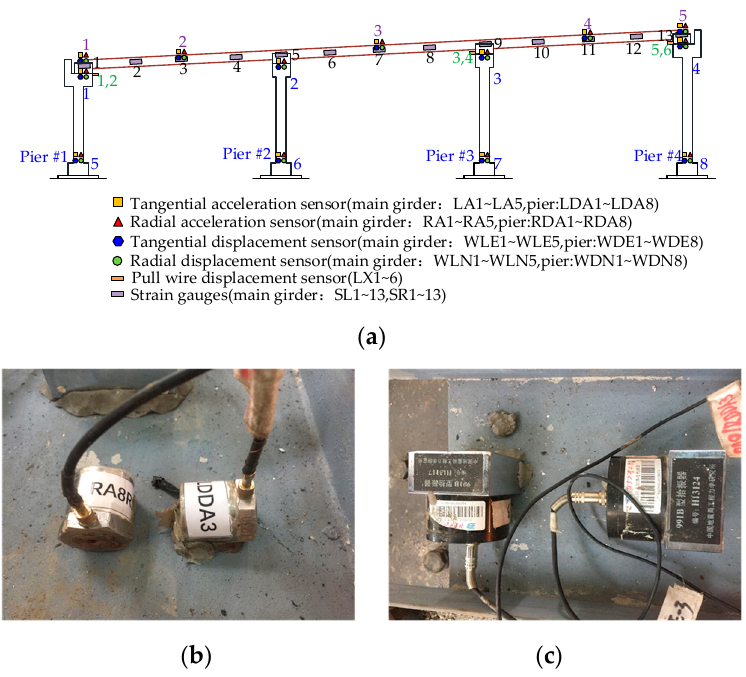
Figure 4. Layout of sensors. ( a ) Details of the sensors installed on the bridge model. ( b ) Layout of acceleration sensors. ( c ) Layout of displacement